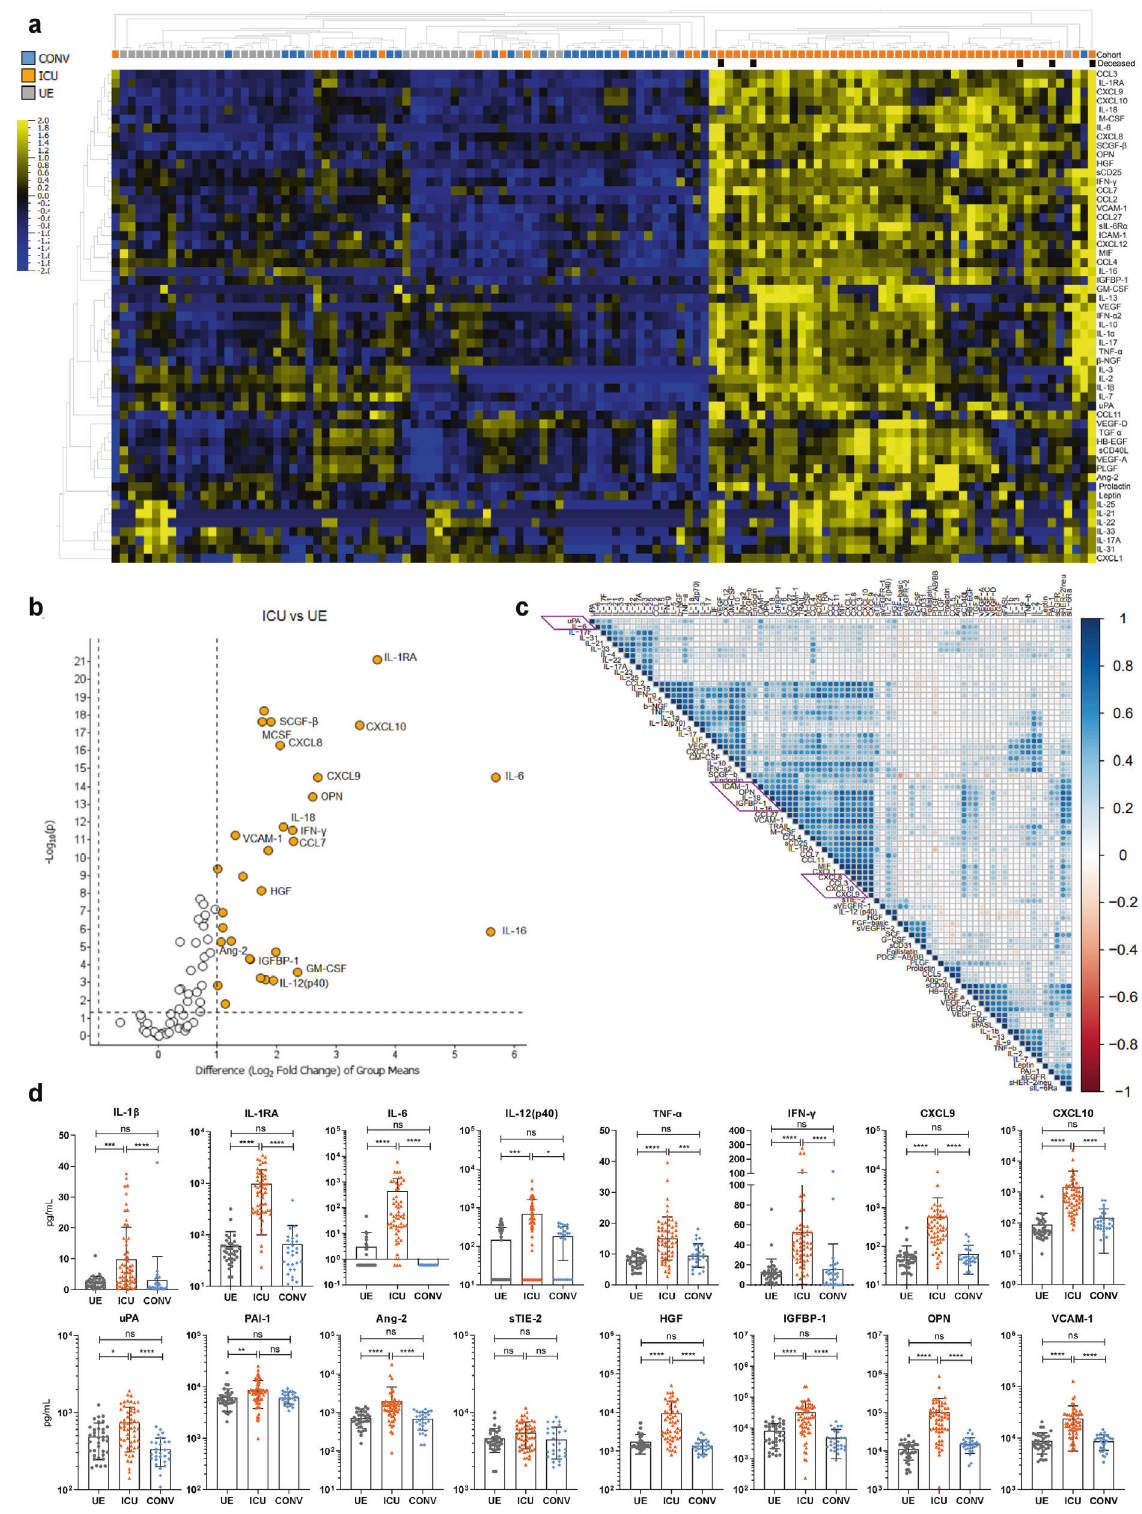
with fatal outcome. To identify the most statistically signi fi cant plasma proteins discriminating ICU from UE, we analyzed their levels based on the fold change between ICU and UE (Fig. 5b). The volcano plot illustrates a COVID-19-associated plasma protein pro fi le composed of pro-in fl ammatory cytokines and chemokines Signal Transduction and Targeted Therapy (2021)